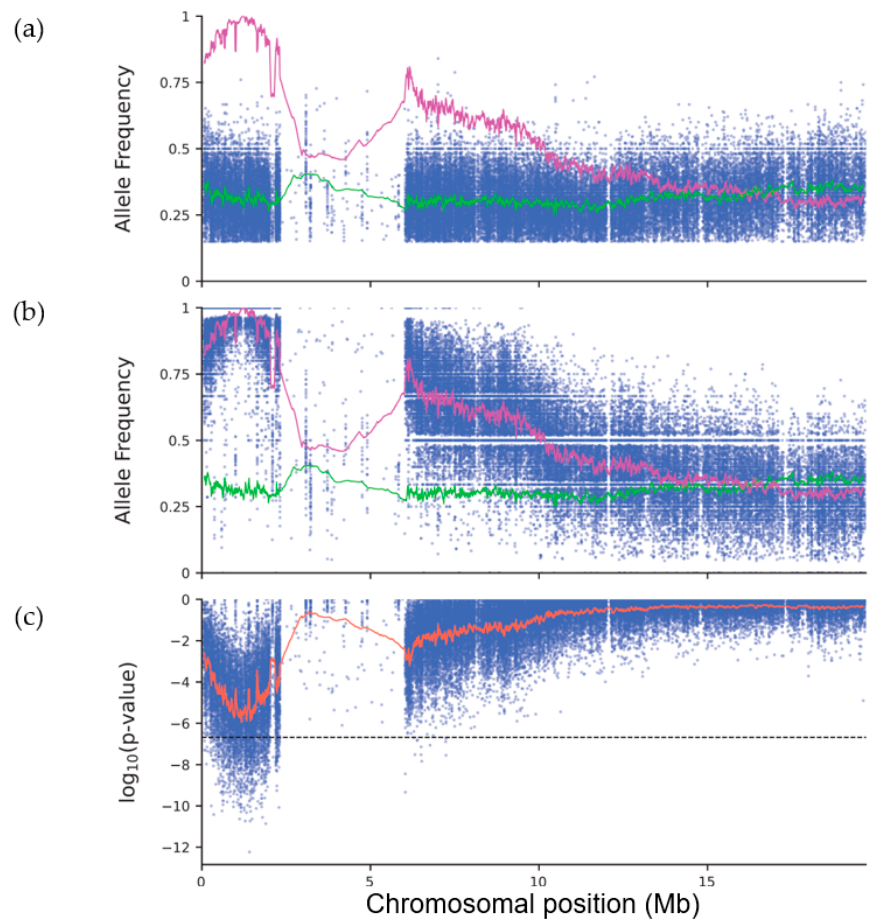
Figure 2. Mapping-by-sequencing of the recessive allele causing the albino seedling phenotype. The plots correspond to markers located on chromosome 2. ( a ) Frequency of alleles inherited from the mutant parent in a pool of F 2 seedlings exhibiting the wild-type (photosynthetic) phenotype. ( b ) Frequency of alleles inherited from the mutant parent in a pool of F 2 seedlings exhibiting the mutant (albino) phenotype. ( c ) p -values of two-tailed Fisher’s exact tests performed on the same dataset. Each blue dot indicates the allele frequency ( a , b ) or the p -value ( c ) of a biallelic SNP segregating in the population. The green line corresponds to the moving average of the allele frequencies of 200 adjacent SNPs, as determined in the pool of wild-type plants. The pink line corresponds to the moving average in the pool of mutant individuals. Both moving averages are shown in ( a , b ) to facilitate their comparison. The red line corresponds to the weighted moving average of the p -values. The dashed line marks the significance threshold, calculated using the Bonferroni correction, considering that n = 237,774 chromosomal locations were tested.